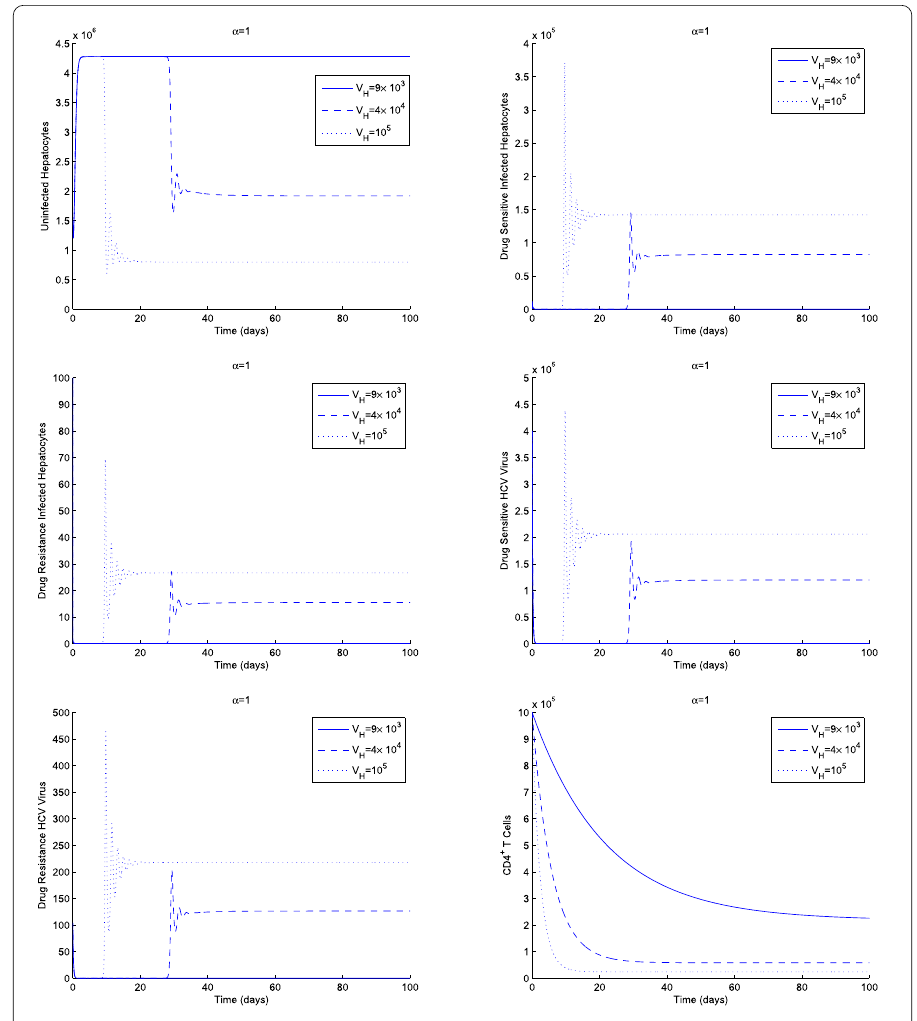
Figure 1 Dynamics of the variables of system (1) for different values of V H , the HIV viral load, and α = 1.0. Parameter values are in Table 1 and initial conditions are in the